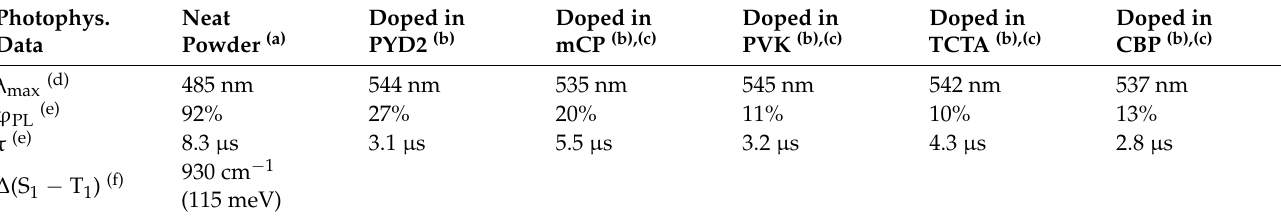
Table 1. Photophysical data of Cu 2 Cl 2 (P ∩ N) 2 measured at 300